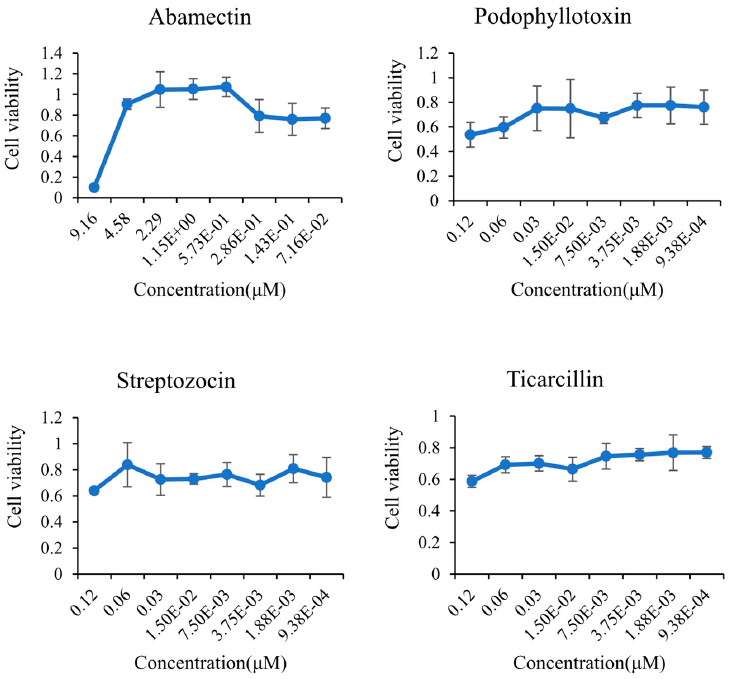
Figure 4. The cytotoxicity test of Abamectin and Podophyllotoxin, Streptozocin, and Ticarcillin at different concentrations.